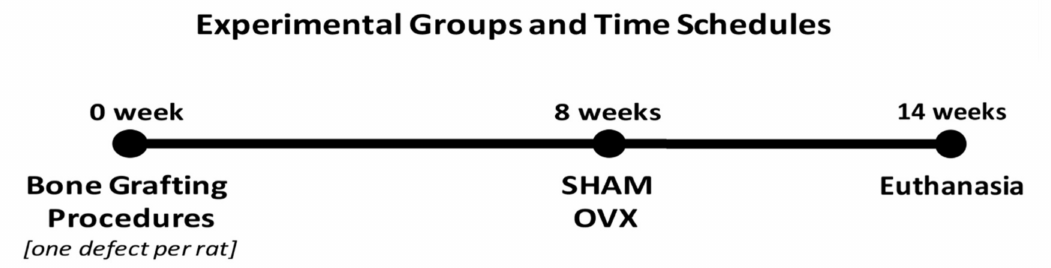
Figure 2. Experimental animal groups and timeline for surgical procedures and sacrifice in study